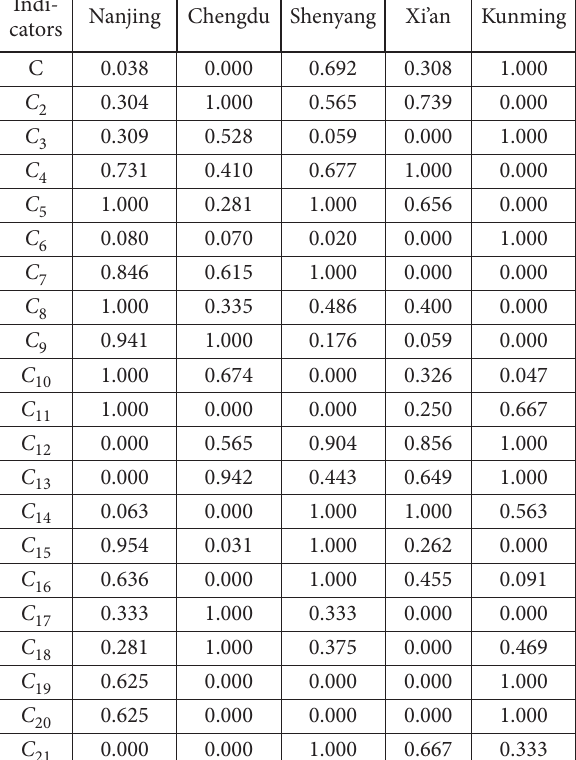
Table 5. Normalized result (C Level) of disaster prevention